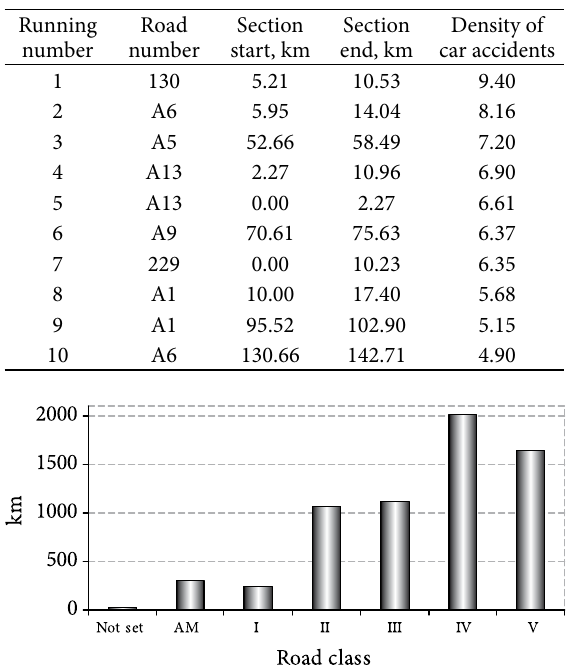
Table 4. Top 10 road sections with the highest density of car accidents that occurred on Lithuanian main and interurban road networks during the years 2002–2006